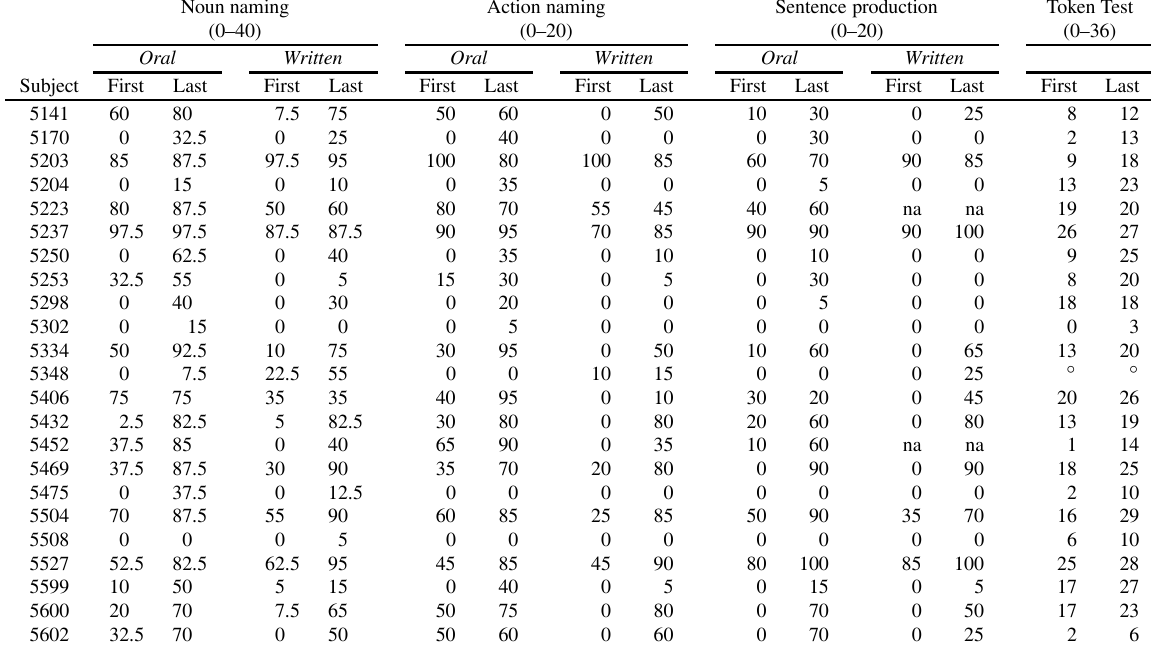
Table 4 Percentage of correct responses in oral and written noun and action naming, sentence production, and Token Test’s scores at fi rst and last